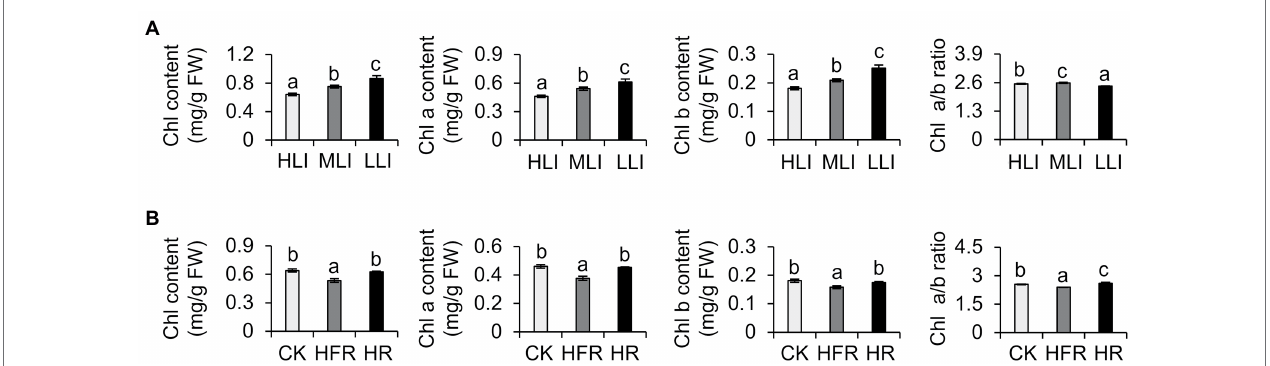
FIGURE 3 | Effect of decreased light intensity and changes in light quality on the chlorophyll level of cut tea branches. (A) Changes in the chlorophyll levels of cut tea branches under decreased light intensity treatment. HLI: high light intensity treatment group (252 μ mol m − 2 s − 1 ); MLI: medium light intensity treatment group (84 μ mol m − 2 s − 1 ); LLI: low-light intensity treatment group (3.36 μ mol m − 2 s − 1 ), and R: FR for all three groups were 1.5. (B) Changes in chlorophyll levels of cut tea branches after light quality changes. CK: R: FR was 1.5; HFR: high far-red group, R: FR was 0.1; HR: high red group, R: FR was 7, and the light intensity of